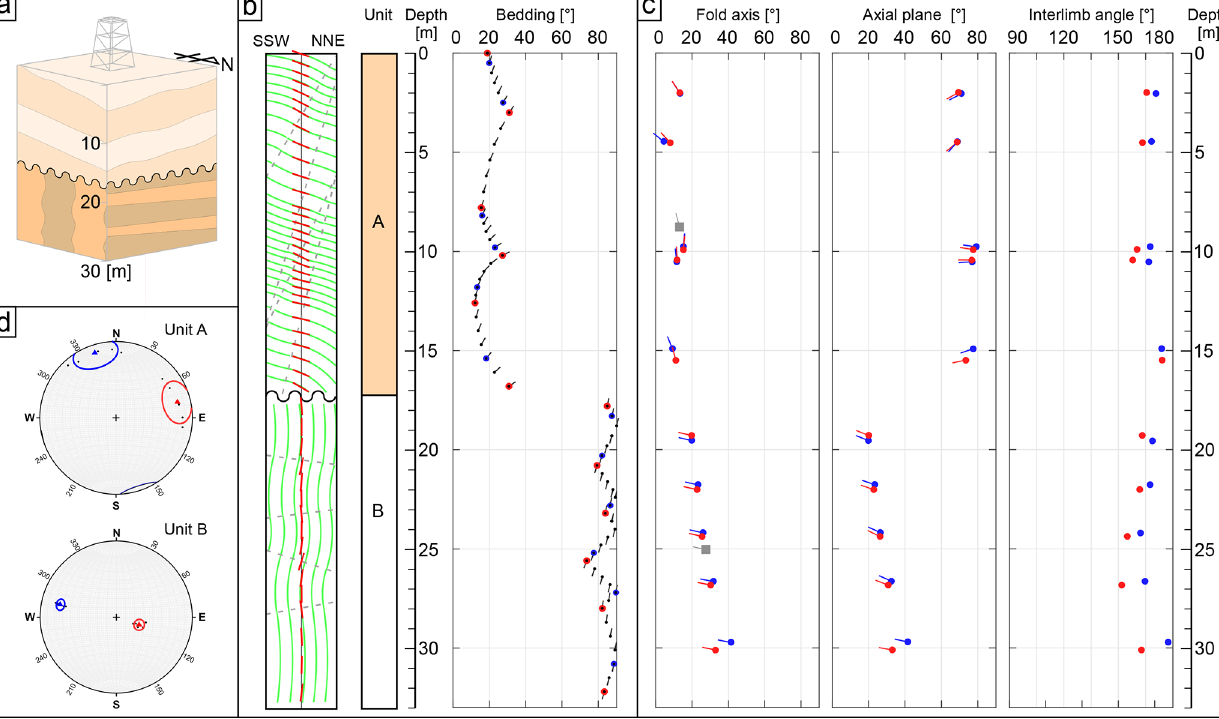
Figure 4. Results of applying the proposed method to the simulated fold model. (a) Schematic image of the simulated fold model. (b) Cross section of the simulated fold model, structural units, and a tadpole plot of the orientation of bedding planes that would be interpreted if the simulated formation is drilled. Points identified as inflexion points are indicated by red/blue circles. (c) Fold axes, axial planes, and interlimb angles obtained by applying the proposed method. The grey squares represent the orientation of the fold axes calculated using the Bingham axial distribution for each unit. The difference between the red and blue circles is the same as the colour of the inflexion points used in the calculation. (d) Stereonet of calculated fold parameters. The mean direction (Fisher et al., 1987) of the poles of the axial planes is shown in red and that of the fold axis in blue, representing the direction of maximum principal stress and intermediate stress during fold formation, respectively. Curves of the same colour as the mean vector represent 95% confidence cone for the mean direction (Fisher et al.,